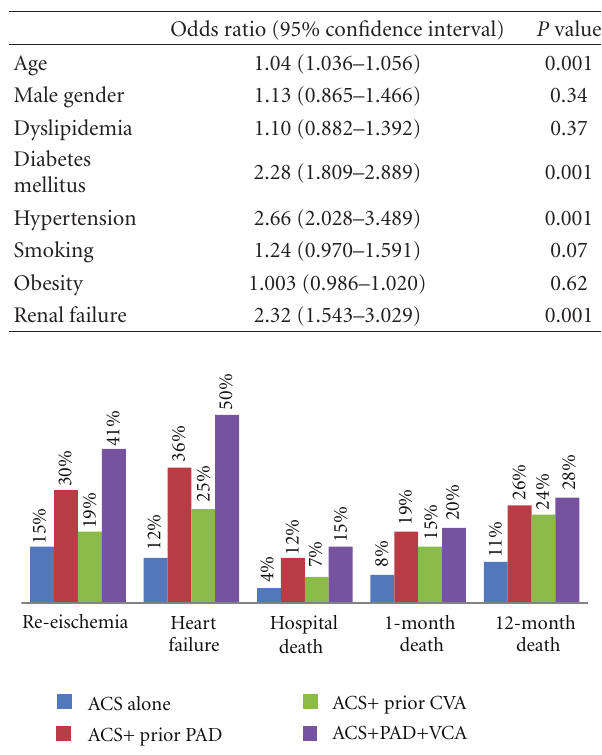
rate even after adjusting for baseline variables. Third ,